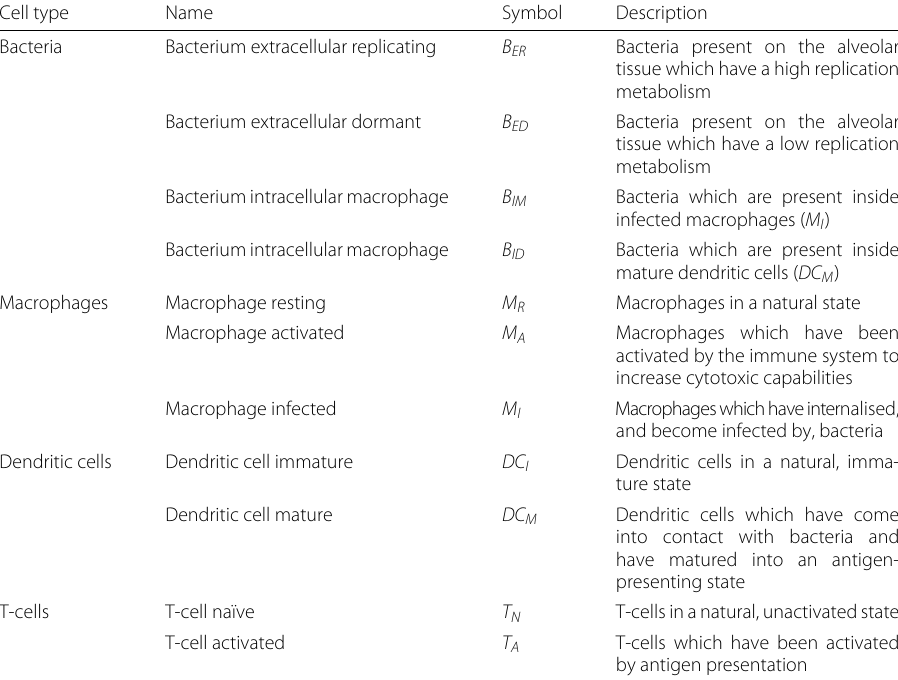
Table 1 Subpopulation compartments used in